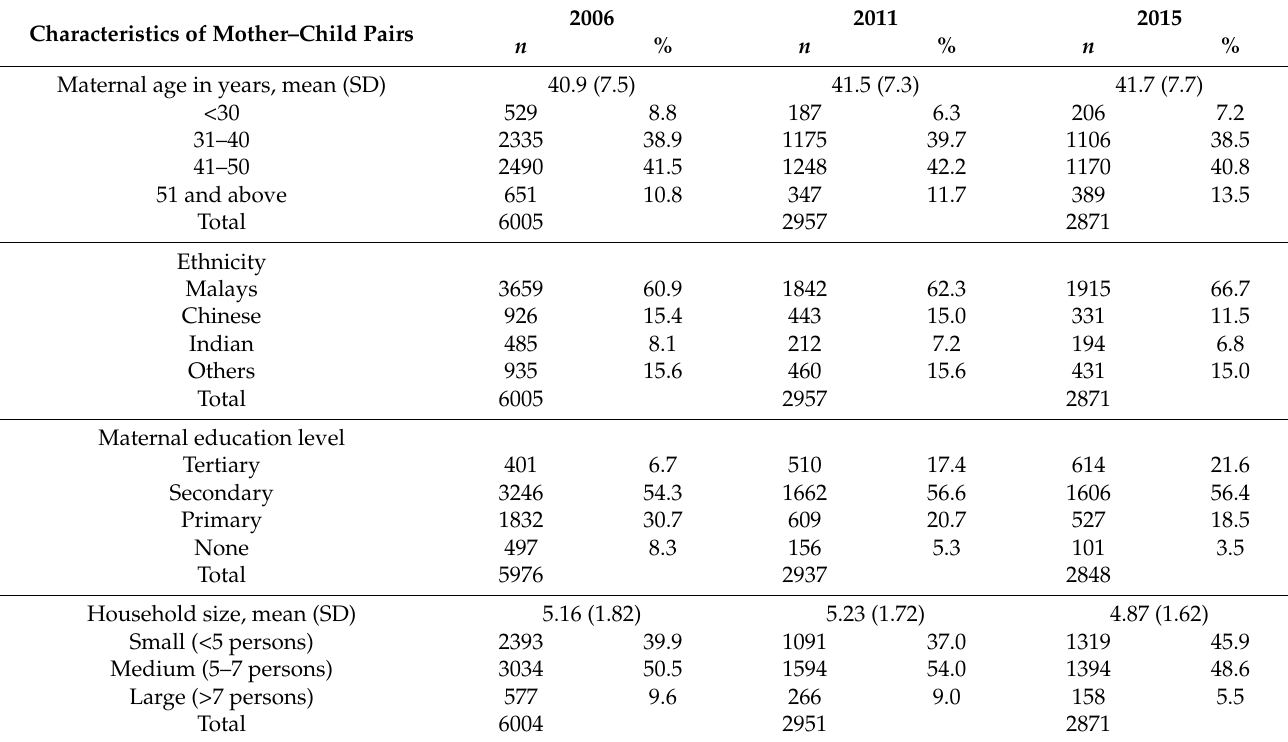
Table 1. Sociodemographic characteristics of mother–child pairs in the National Health and Morbidity Survey of Malaysia in 2006, 2011 and